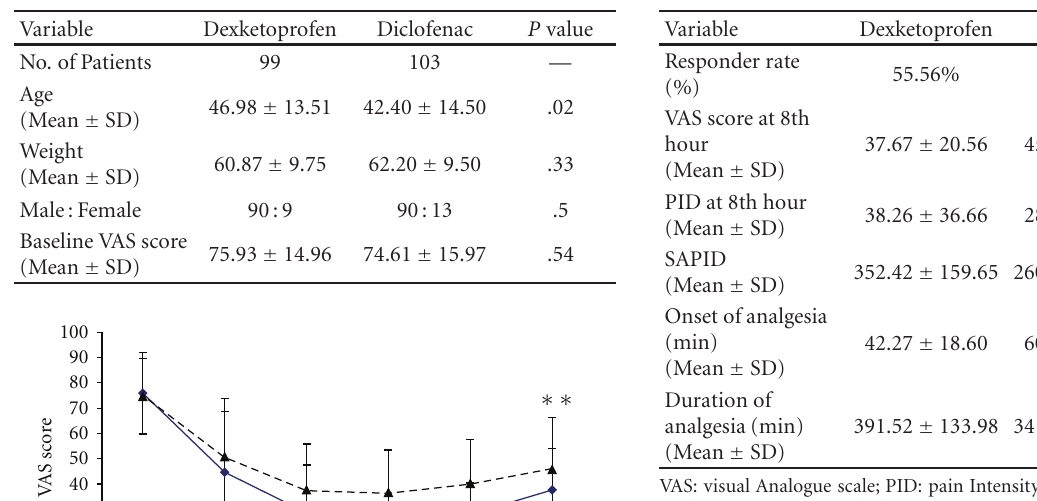
Table 1: Demographic and baseline data.